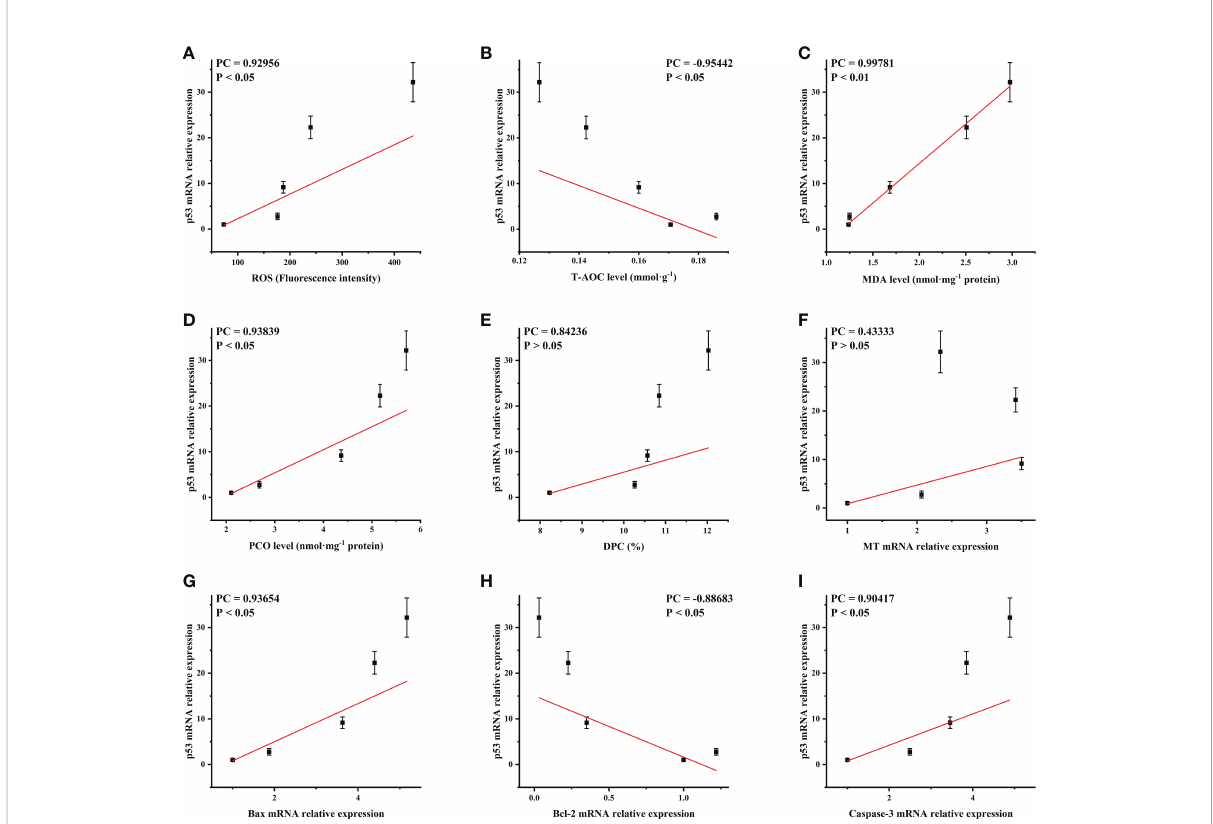
FIGURE 7 Correlation analysis of p53 mRNA expression with the oxidative damage-related and apoptosis-related markers. Oxidative damaged-related markers: (A) ROS; (B) T-AOC; (C) MDA; (D) PCO; (E) DPC; (F) MT. Apoptosis-related factors: (G) Bax; (H) Bcl-2; (I) Caspase-3. PC, Pearson correlation coef fi